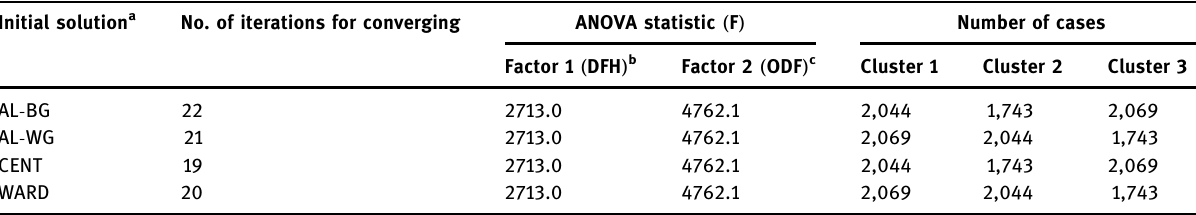
Table 7: Results of the k - means applied to di ff erent initial solutions Initial solution